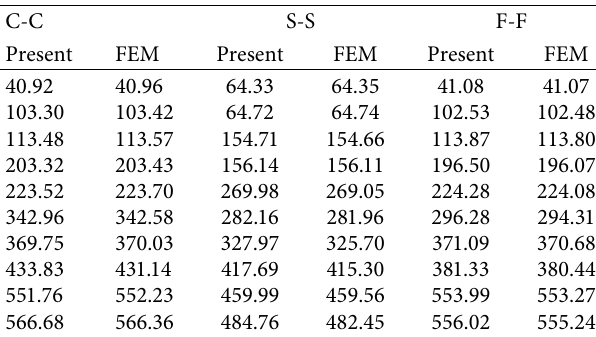
Table 5: Comparison of the first 10 natural frequencies of the whirl line structure under different boundary conditions. C-C S-S F-F Present